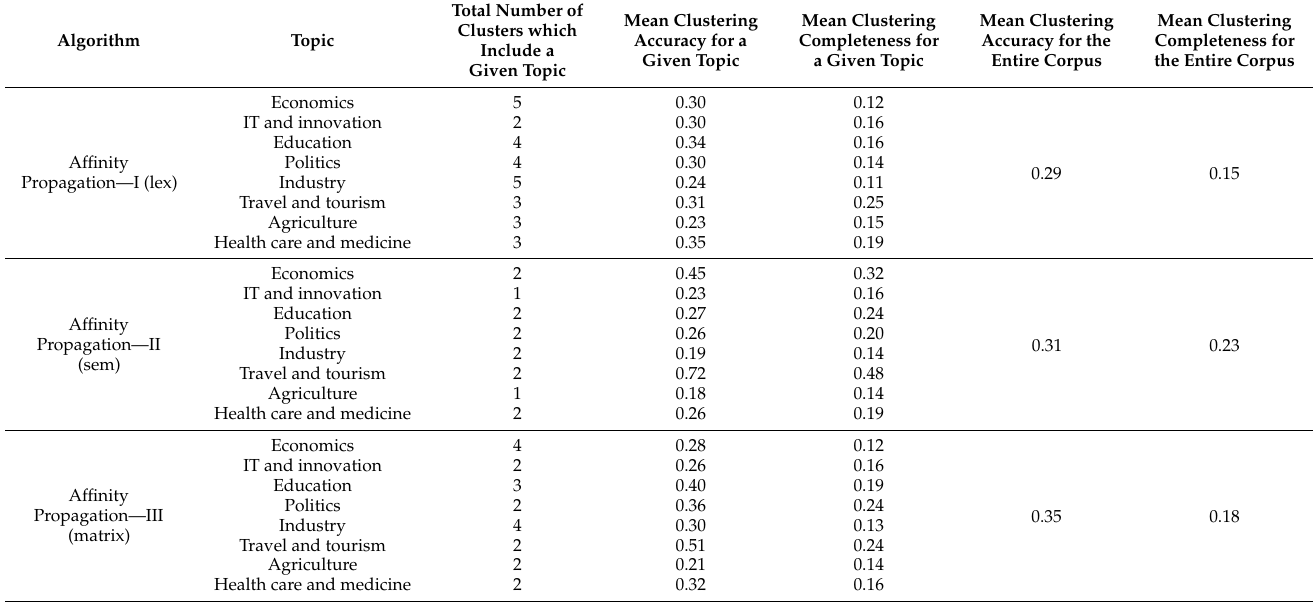
Table 3. Assessing the mean values of clustering accuracy and completeness for each of the corpus